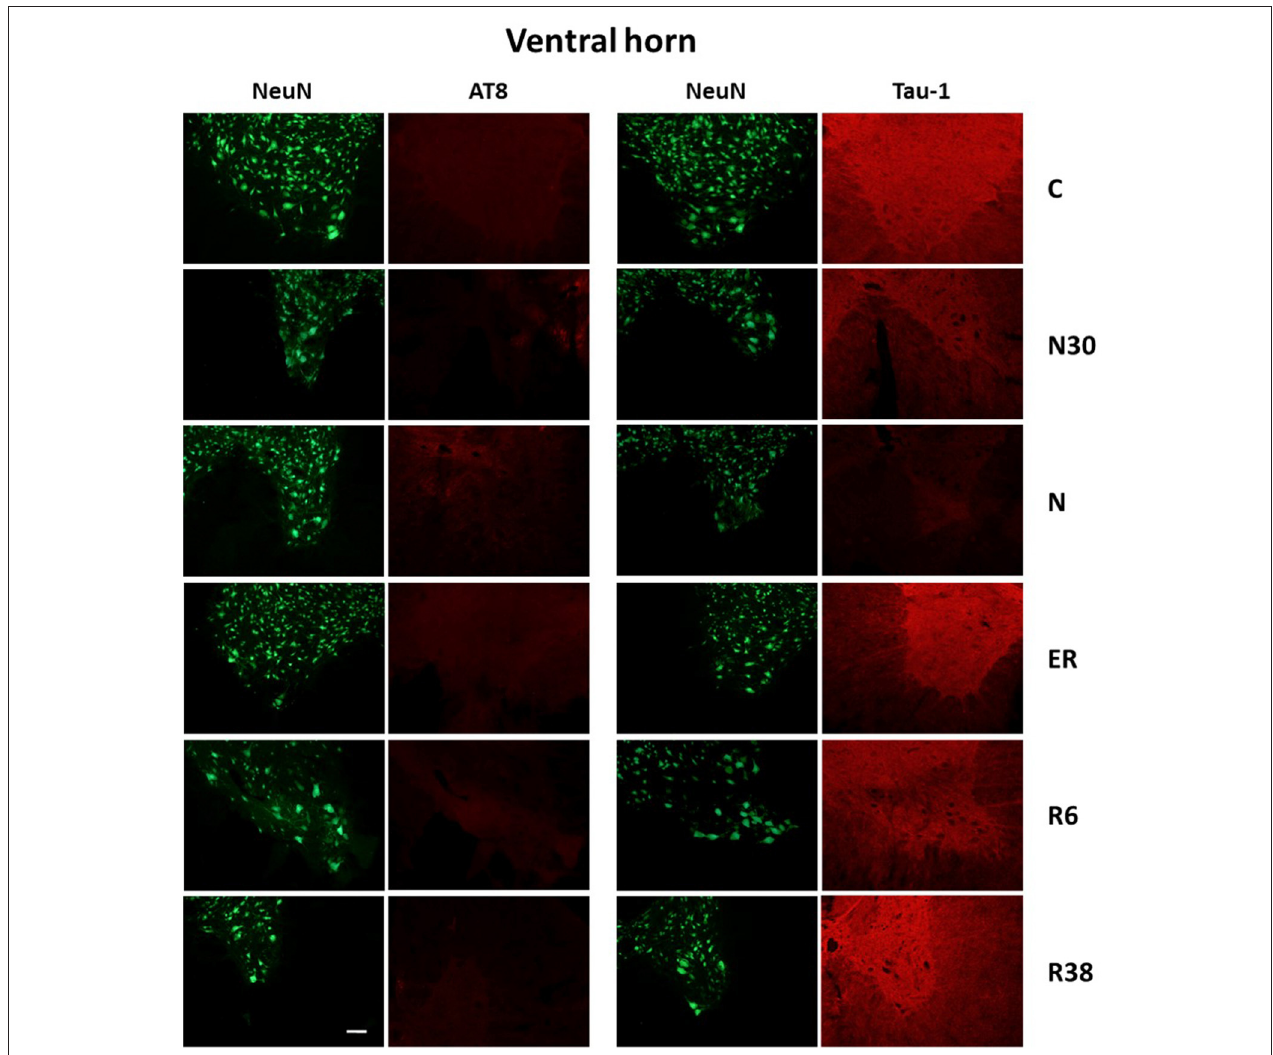
FIGURE 4 | Representative pictures showing the ventral horn of the spinal cord. Green pictures represent NeuN staining (neuronal maker, secondary conjugated with Alexa-488), for the recognition of the anatomical structure. In the left half of the figure, red pictures represent the same corresponding field depicted in the nearby NeuN column, but stained for AT8 (phosphorylated Tau, secondary conjugated with Alexa-594). In the right half of the figure, red pictures represent the same corresponding field depicted in the nearby NeuN column but stained for Tau-1 (non-phosphorylated Tau, secondary conjugated with Alexa-594). C, control; N30, samples taken during the induction of synthetic torpor (ST), when brain temperature (Tb) reached 30 ◦ C; N, samples taken at nadir of hypothermia, during ST; ER, early recovery, samples taken when Tb reached 35.5 ◦ C following ST; R6, samples taken 6h after ER; R38, samples taken 38h after ER. Calibration bar: 100 µ